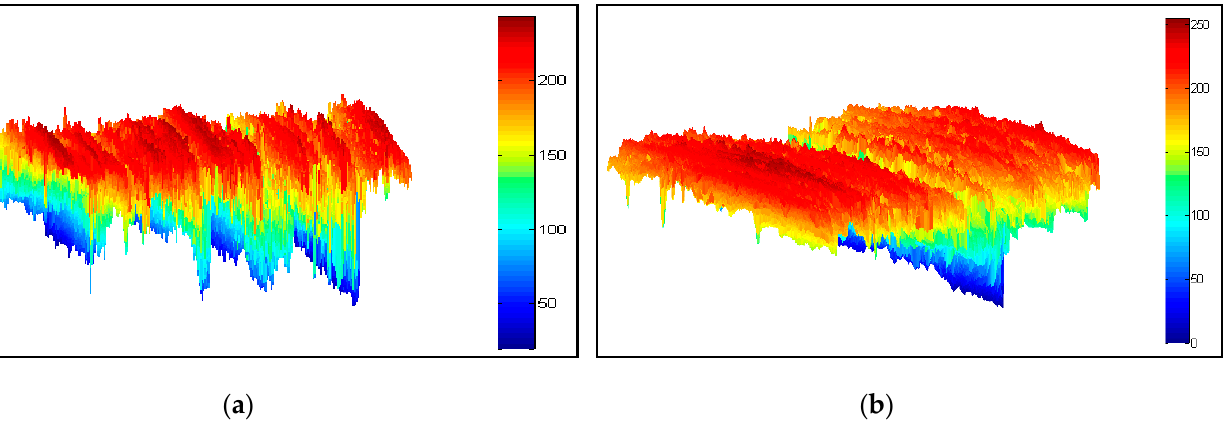
Figure 15. 3D images before and after borehole wall fusion. ( a ) 3D images before fusion, ( b ) 3D graphics after fusion.